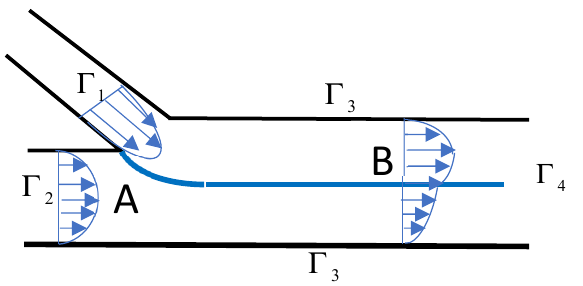
Figure 12. Convergence of two polymer layers at the entrance of a bilayer coextrusion die.